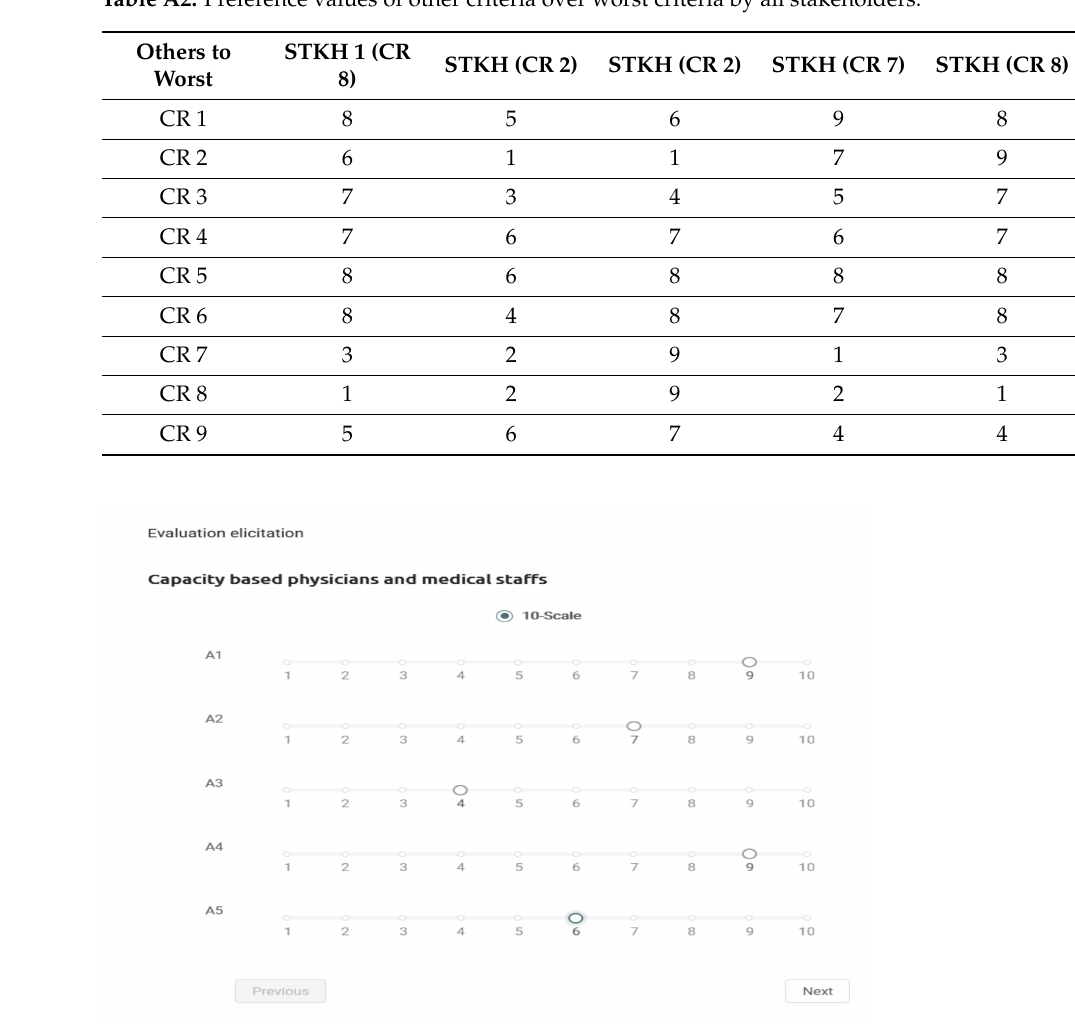
Figure A2. CR 1 compared by STKH1 with all five alternatives.